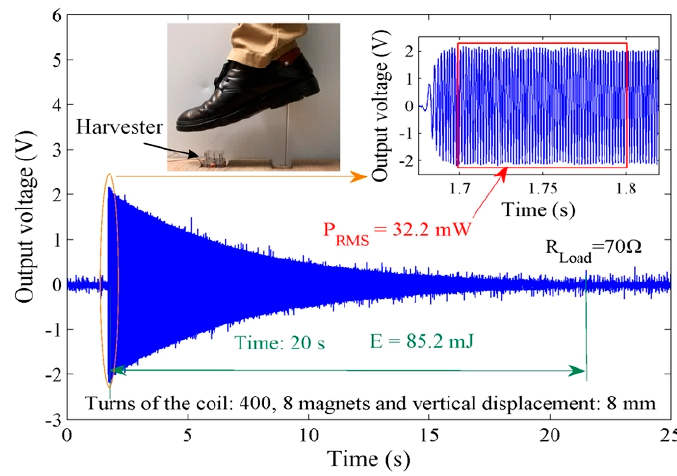
Figure 23. Output characteristic of the smart tile [57].